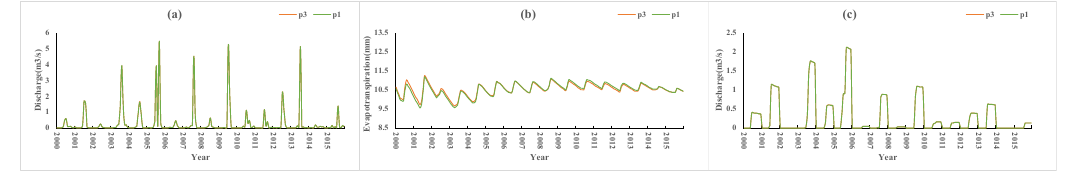
Figure 7. Schematic diagram of surface runoff, farmland runoff, and evapotranspiration.